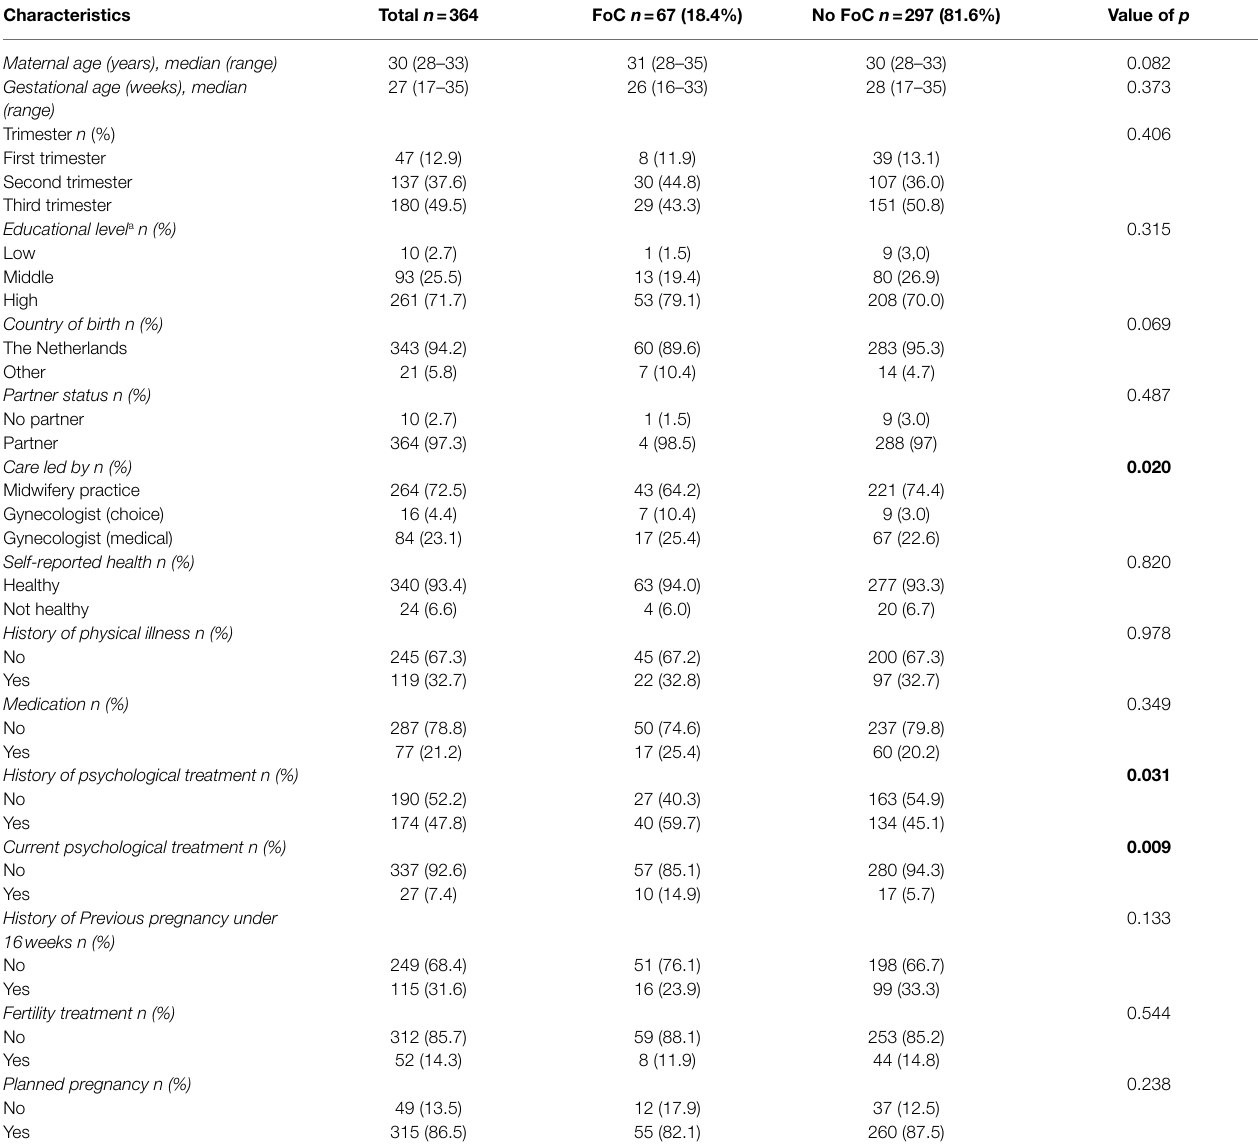
TABLE 1 | Socio-demographic and obstetric characteristics compared per group.